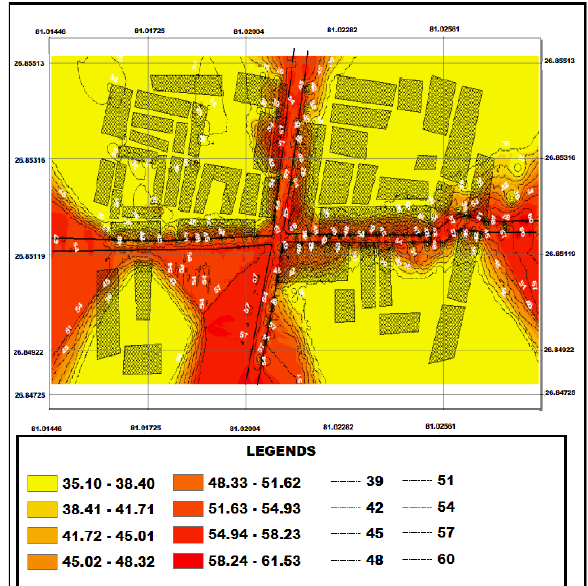
Figure 7. Noise level map of Haniman at afternoon time using NoiseCapture app scaled with standard SPL